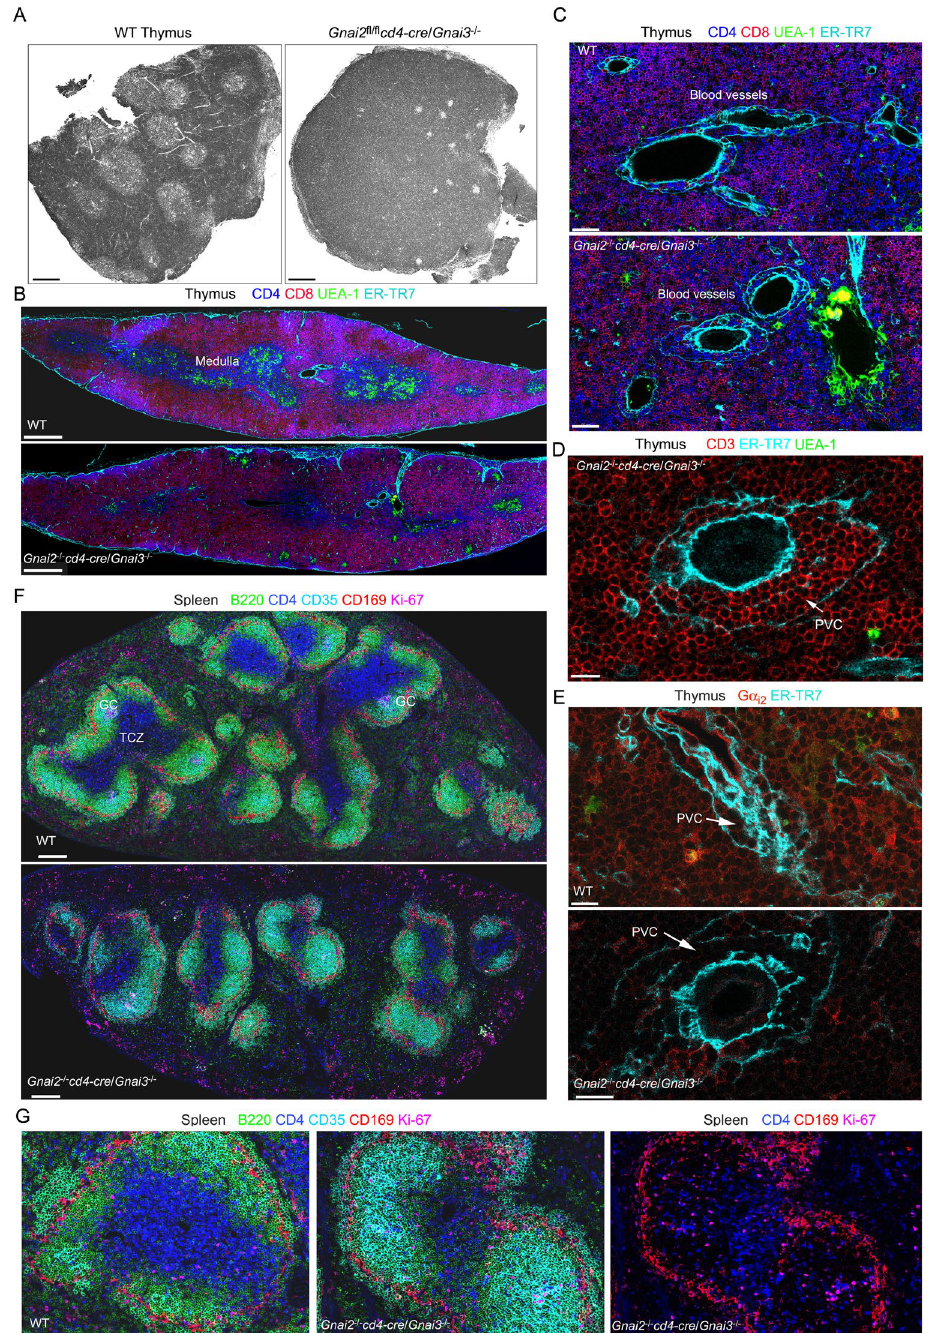
Figure 7. Consequences of deleting Gnai2 in DP thymocytes of mice that lack Gnai3 on lymphoid organ architecture. ( A ) Confocal microscopy image collected with a transmission photomultiplier tube of a hematoxylin & eosin stained thymus sections from the indicated mice. Scale bar is 300 μ M. ( B ) Confocal microscopy of a thymus section from the indicated mice immunostained for CD4, CD8, UEA-1, and ER-TR7. Acquired images tiled together to span a single thymus lobe. Scale bar are 400 μ M. ( C ) Electronically zoomed images from part B focused on a likely site of thymocyte egress. Scale bar is 50 μ M. ( D ) Confocal microscopy of a thymus section from a DKO mouse immunostained for CD3, ER-TR7, and UEA-1 focused on a likely egress vessel. The perivascular channel (PVC) is indicated. Scale bar is 15 μ M. ( E ) Confocal microscopy of thymus sections from the indicated mice. The sections were immunostained for G α i2 and ER-TR7. The PVC is indicated. Scale bars are 15 μ M. ( F ) Tiled confocal images of the spleens of the indicated mice immunostained for B220, CD4, CD35, CD169, and Ki67. The sections are oriented parallel to the short axis of the spleens. Several germinal centers (GC) are evident in the WT spleen. ( G ) Zoomed image of a splenic follicle of the indicated mice from F. The sections were immunostained for B220, CD4, CD35, CD169, and Ki-67. In the far right image the B220 and CD35 signals have been removed. Scale bars are 60 μ